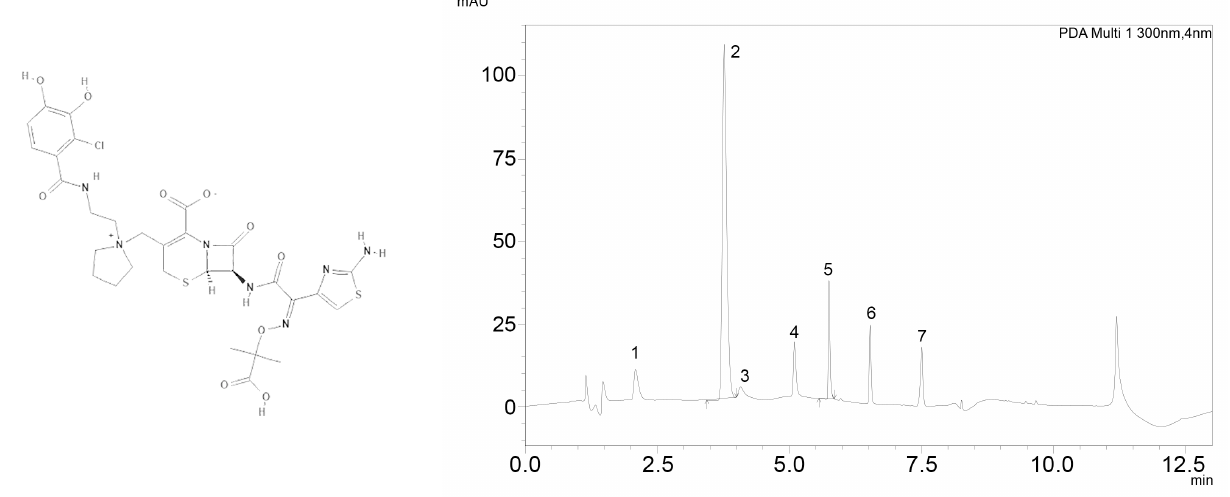
Figure 1. Left: chemical structure of cefiderocol [15]; right: chromatogramm showing 1:cefepime; 2: metronidazole (internal standard); 3:meropenem; 4: ceftazidime; 5: cefiderocol; 6: cefotaxime; 7: cefuroxime. Table 1. Results of the HPLC-UV validation for cefiderocol in